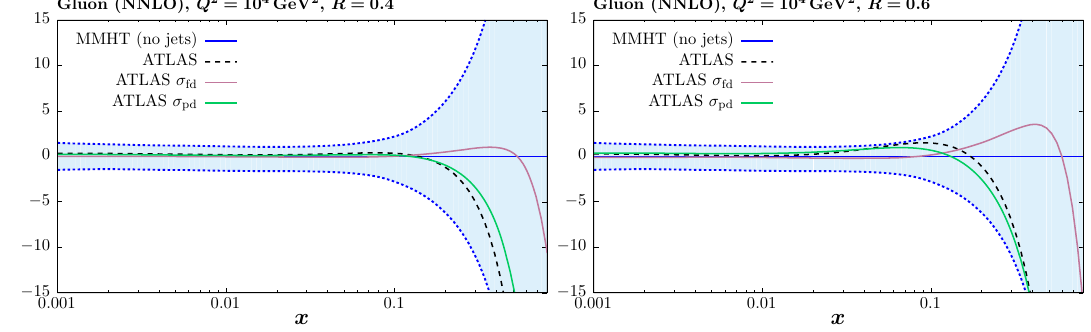
parison to the baseline fit, with no jet data included, is shown. The jet radii R = 0 . 4 (0.6) ATLAS data is used in the left (right)